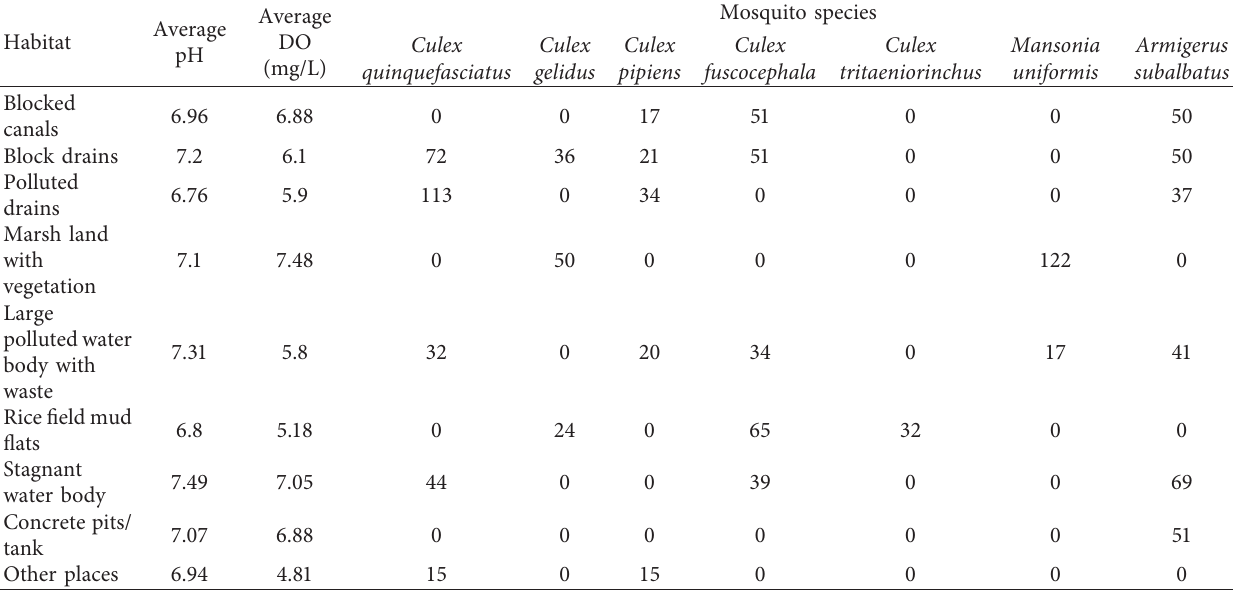
Same superscript in the column is not significantly different at p ≤ 0.05. Table 4: Mean density of mosquito species larvae collected from different breeding